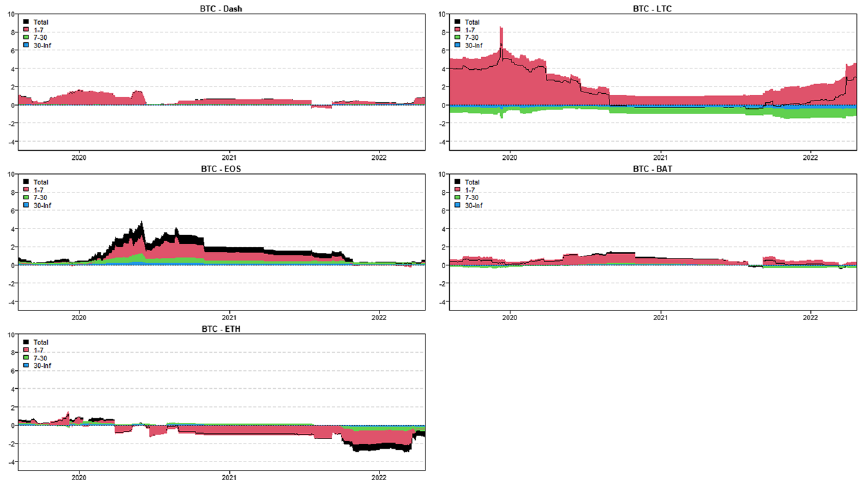
Fig. 28 Dynamic net-pairwise connectedness—realized hyperskewness